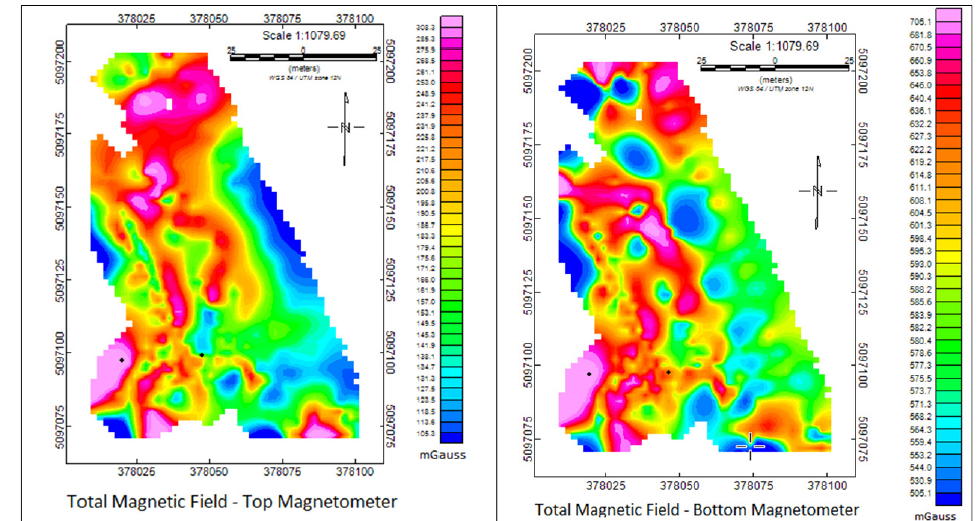
Figure 5. Left panel: the total magnetic field measured by the top magnetometer. Right panel: the total magnetic field measured by the bottom magnetometer. Note the scale bars have different maximum and minimum values.